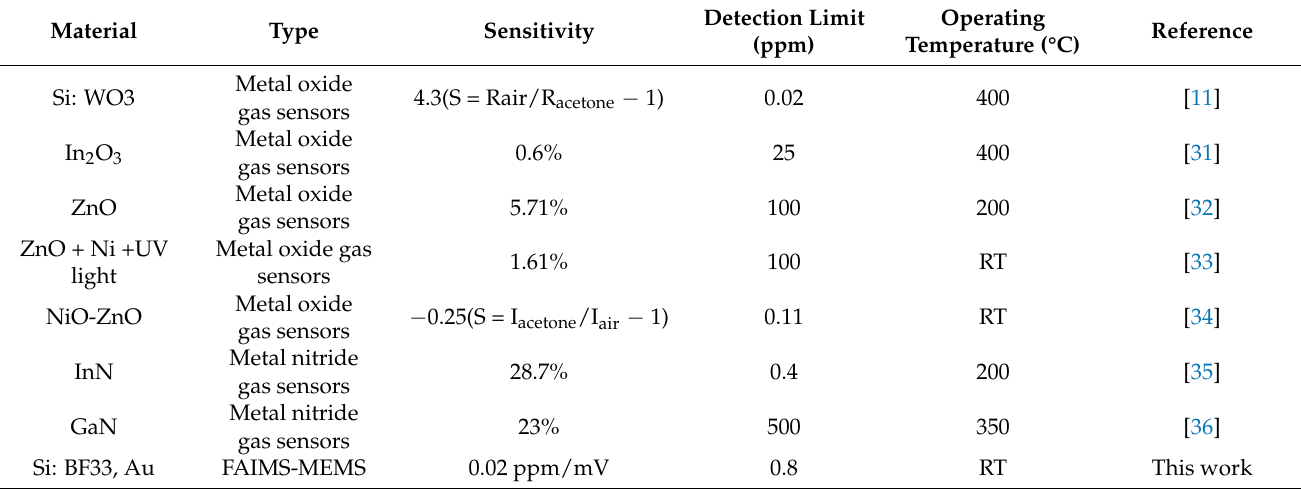
Table 2. The comparison of the present acetone sensor with the common acetone